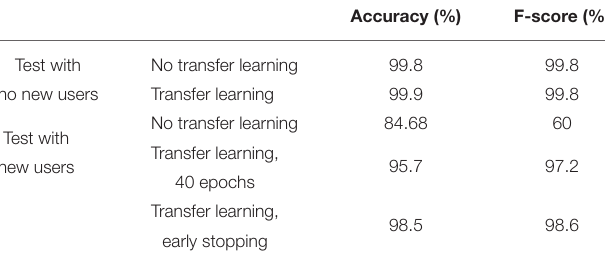
TABLE 1 | Recognition accuracy and f-score with and without transfer